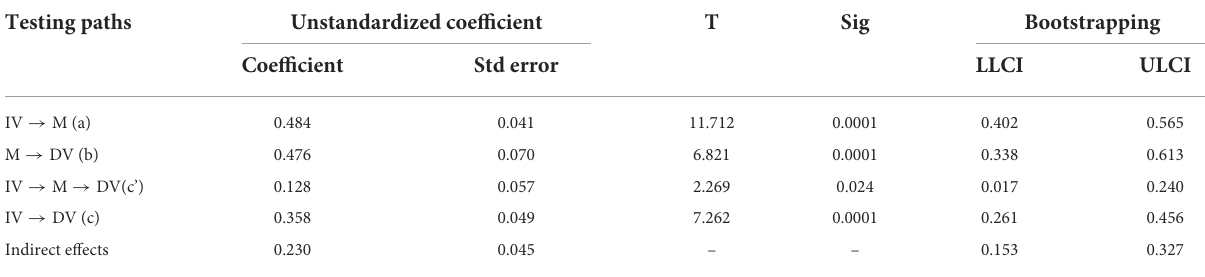
TABLE 5 Coefficient and bootstrapping for the mediation analysis. Testing